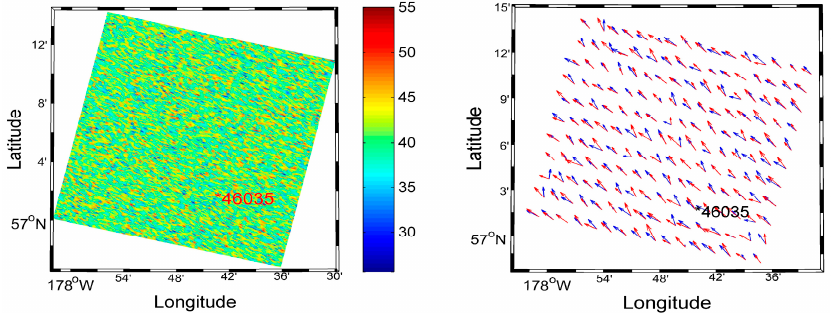
Figure 6. Distribution map for retrieved ocean currents ( left : units are centimeters per second) and directions ( right : units are degrees, blue vectors are retrieved-ocean directions and red vectors are measured by HF radar, respectively). The ocean current speed is 42 cm/s and corresponding current direction is 317.6° at buoy #46035. Table 1. Winds retrieved from fully polarimetric SAR images and NDBC buoy #46035, ocean surface currents measured by HF radar and retrieved ocean currents. Parameters of four kinds of data are simultaneous and collocated. Data are received on 9 January 2012.